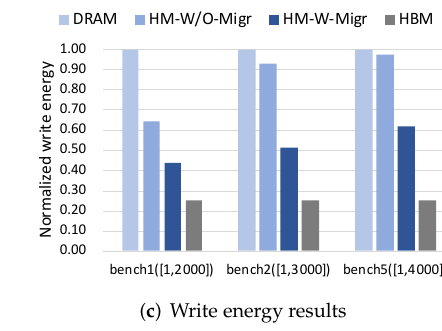
Figure 7. Normalized results across different size